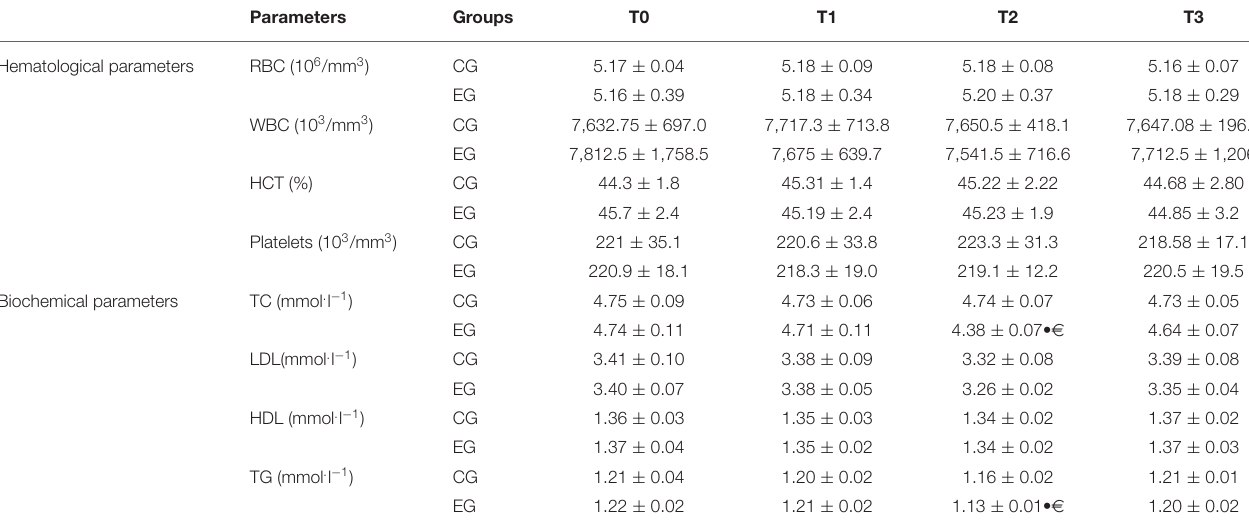
TABLE 2 | Biochemical and hematological parameters (mean ± SD) of the experimental group (EG, n = 12) and control group (CG, n = 12) measured before the start of Ramadan (T0), on the 15th day of Ramadan (T1), the end of Ramadan (T2) and after Ramadan